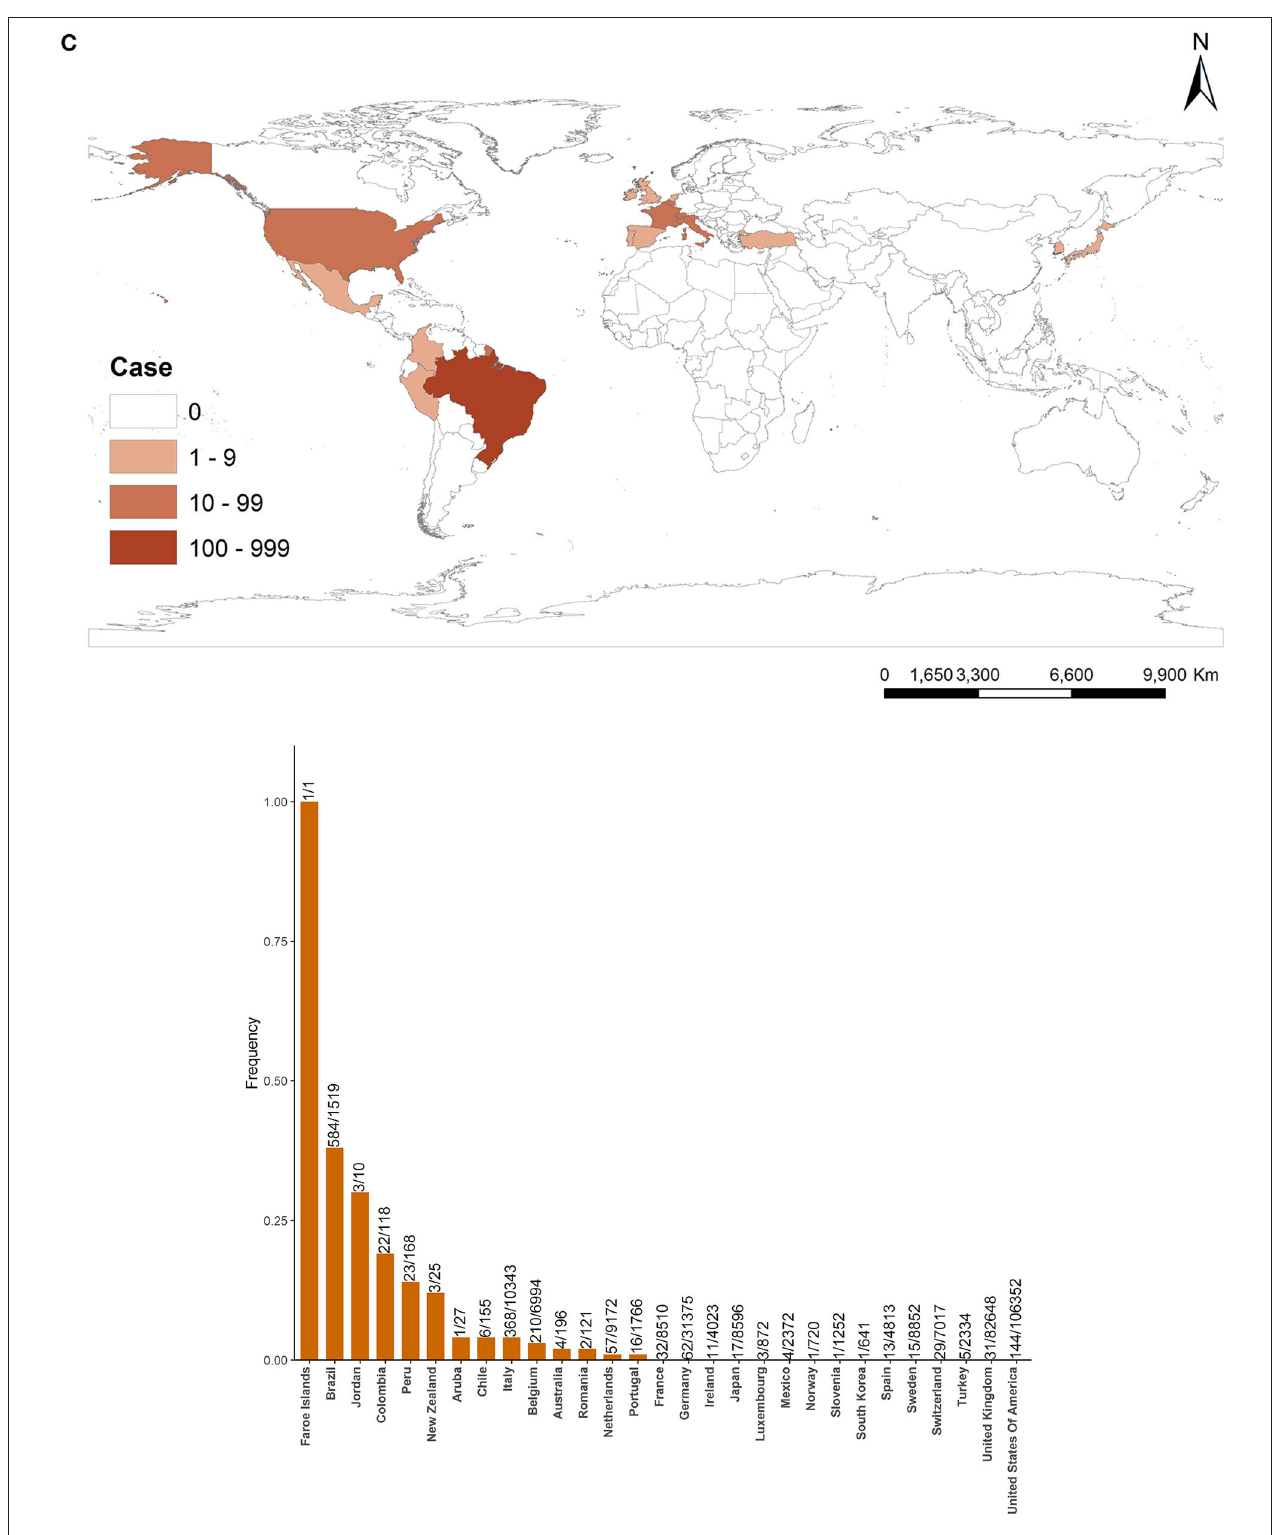
FIGURE 3 | Countries, territories, and areas reporting new variants [ (A) = B.1.1.7, (B) = B.1.351, (C) = P.1]. The upper part of (A–C) represents the global distribution of variants, and the lower part of (A–C) represents the frequency of variants defined that the number of variant sequences divided by the number of total sequences since the first variant